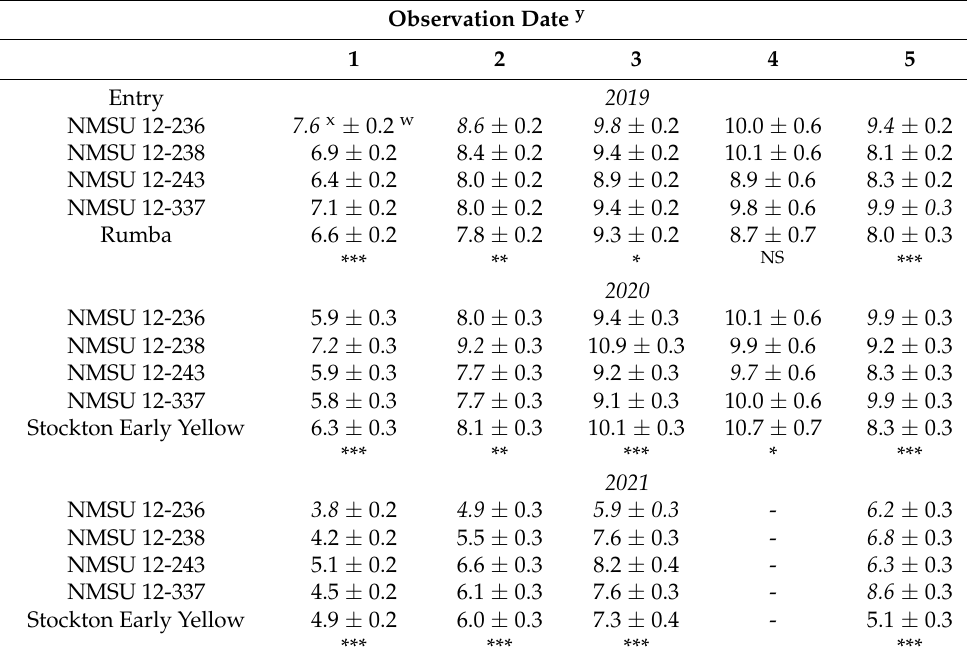
Table 1. Leaf number means measured five times, biweekly, on per plant basis for five onion entries grown at the Fabian Garcia Science Center and Leyendecker Plant Science Research Center, Las Cruces, NM, during the 2019, 2020 and 2021 growing seasons z